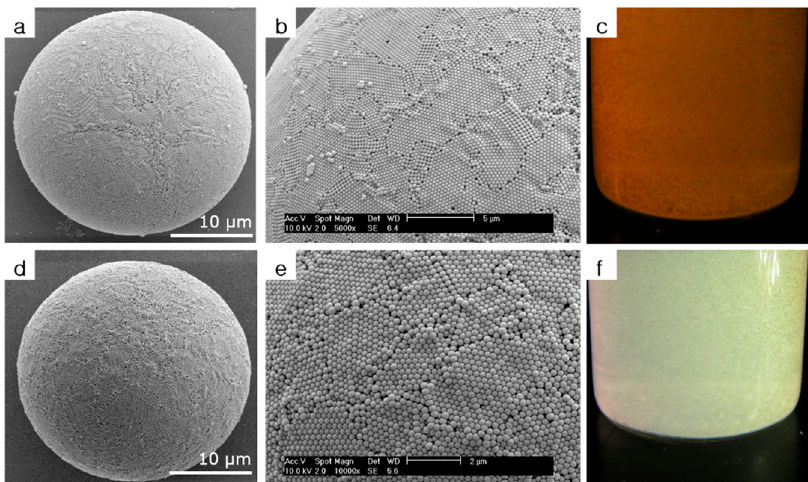
Figure 2. ( a , b ) SEM images and ( c ) digital camera image of spherical opal structures made of 280 nm-sized PS/HEMA nanoparticles. ( d , e ) SEM images and ( f ) digital camera image of spherical opal structures from 210-nm-sized PS/HEMA nanoparticles.